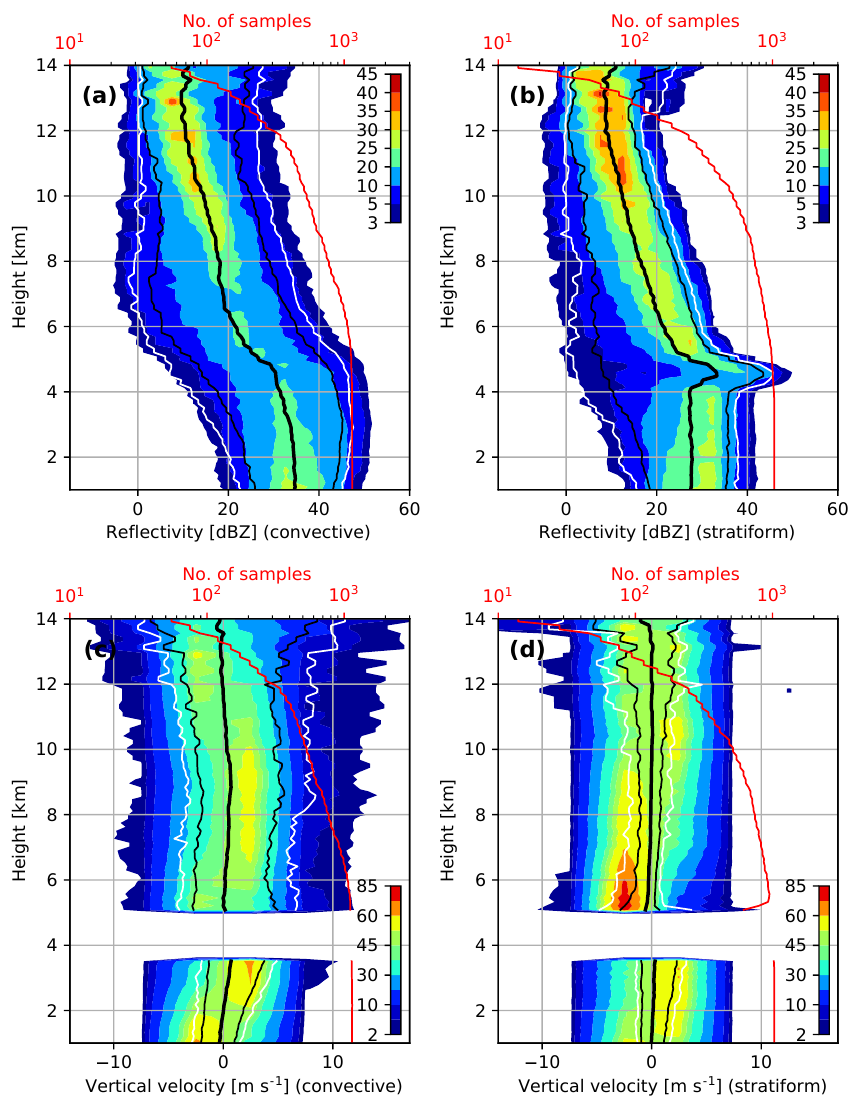
Figure 3. Contoured frequency altitude display (CFAD) histograms for the entire Amazon dataset with confidence intervals, the median (thick black lines) and 90th (thin black lines) and 95th percentiles (white lines) for RWP convective and stratiform reflectivity profiles (a, b) and vertical velocity retrievals (c, d) . The number of profiles of each situation is shown as a red